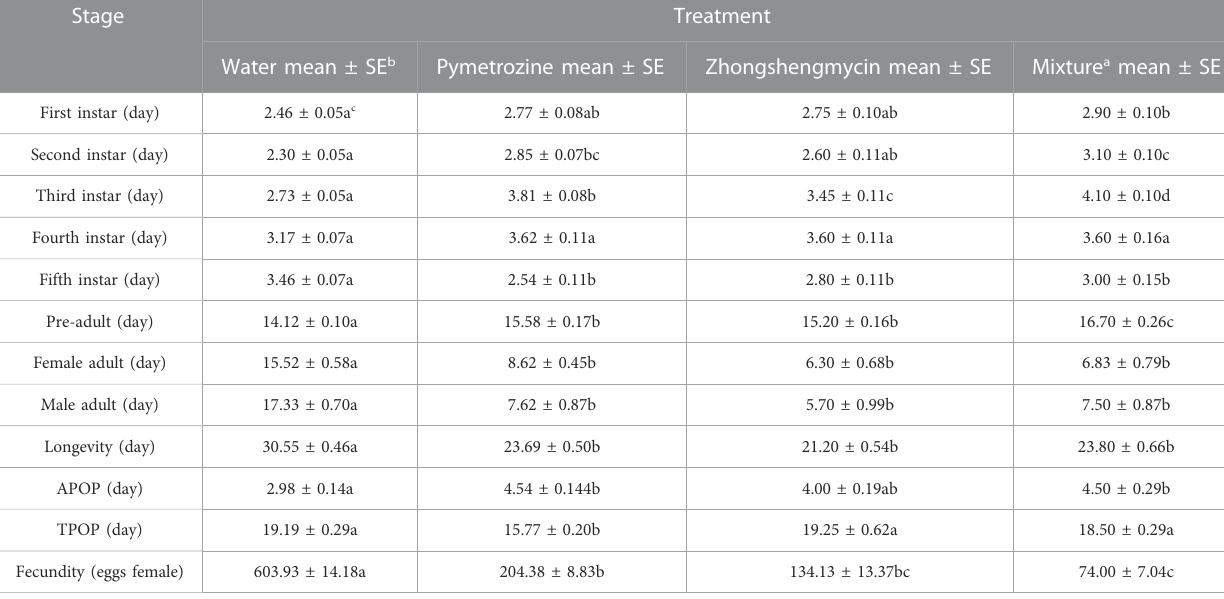
TABLE 1 Developmental period of N. lugens after treatment with different pesticides and